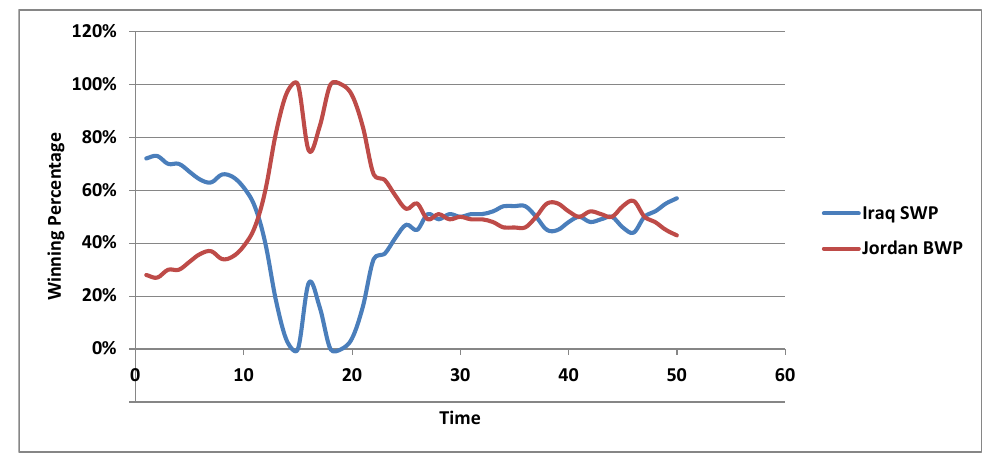
Figure 4. Winning percentage curves for Jordan and Iraq in the oil deal. The graph displays the winning rates as a function of time (data